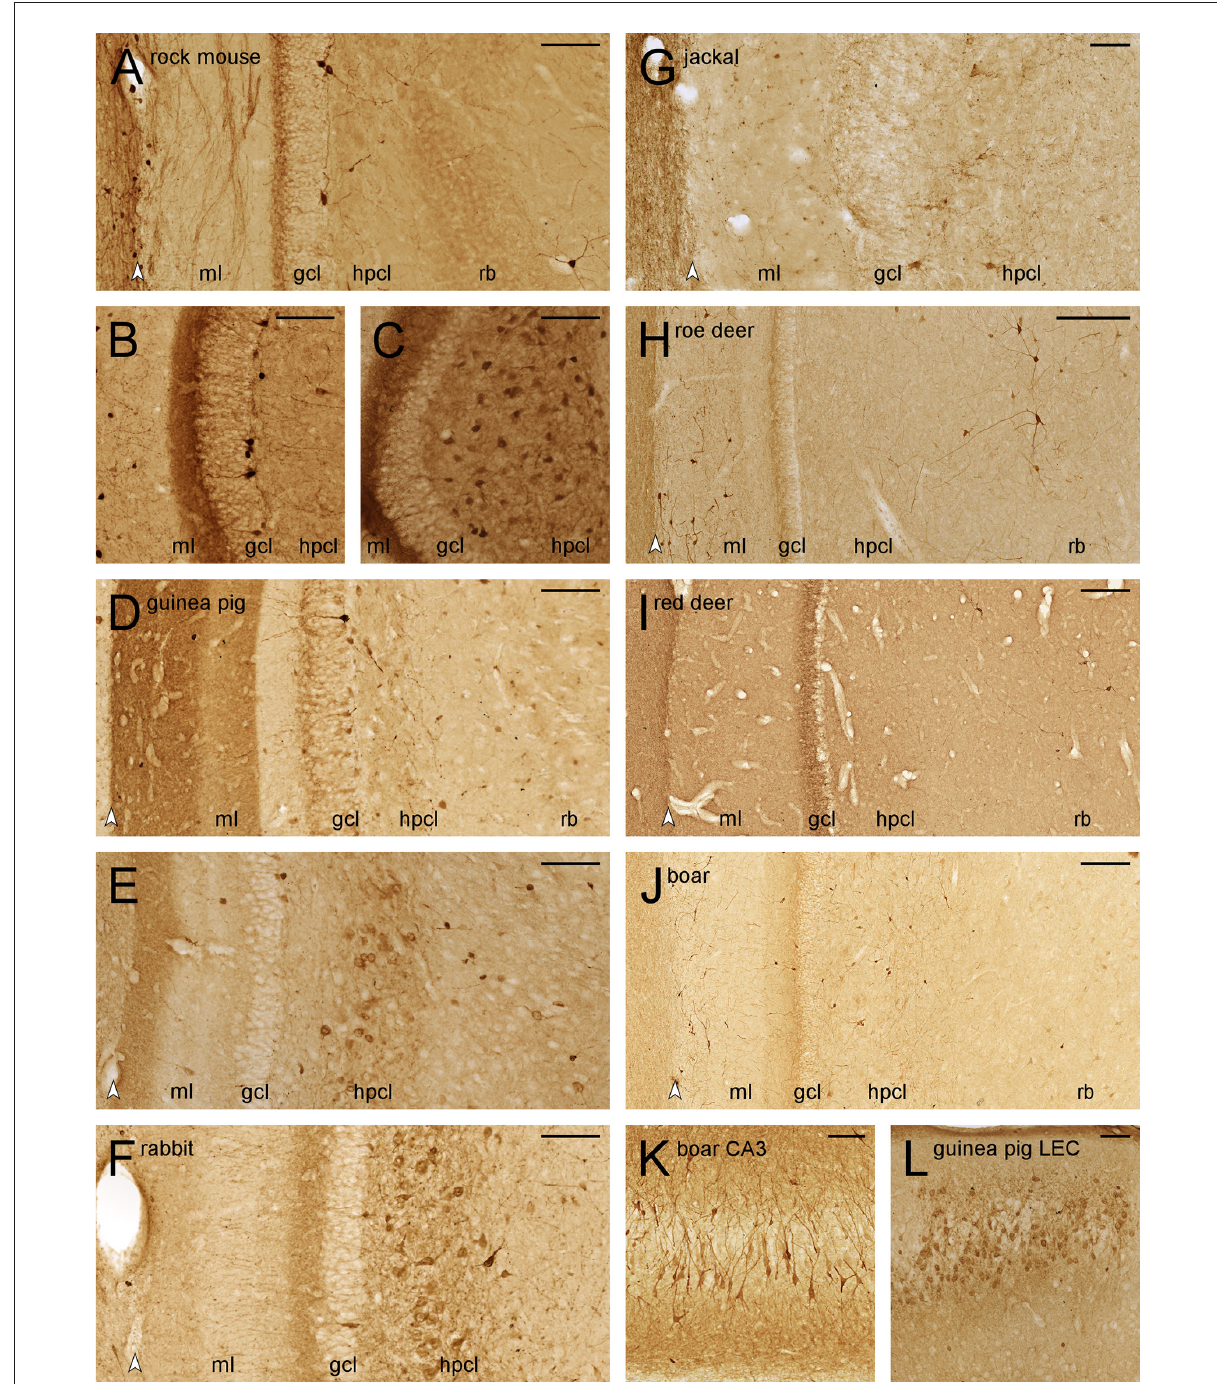
FIGURE6 Calretinin-like immunoreactivity in the dentate gyrus. Septal (A) , temporal (B) , and extreme temporal (C) dentate gyrus of the rock mouse. While CR+ interneurons are found throughout the septotemporal axis of the dentate gyrus, frequent CR+ cells in the hilar polymorphic layer (hplc) are only seen at the temporal pole. Septal (D) and temporal (E) dentate gyrus of the guinea pig. Frequent CR+ are only found in the far temporal dentate gyrus. (F) Frequent CR+ cells are seen in the hplc of the temporal dentate gyrus of the rabbit. In the jackal (G) , roe deer (H) , red deer (I) , and wild boar (J) dentate gyrus, only interneurons are CR+. They are rare in the hplc and frequent in the reflected blade (rb) of both deer, while the pattern is reversed in wild boar. (K) A subpopulation of wild boar CA3 pyramidal cells is CR+. (L) CR+ cells are frequent in the cell island of the lateral entorhinal cortex (LEC) of the guinea pig. White arrowheads mark the borders between the hippocampal and dentate molecular layers. Abbreviations: ml, molecular layer; gcl, granule cell layer; hplc, hilar polymorphic layer; rb, reflected blade of CA3. Scale bars: (A–G,K, and L) 100 µ m; (H–J) 250 µ